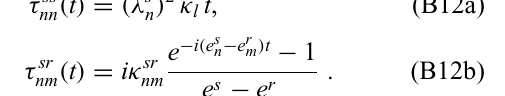
| ˆ J | φ + (cid:2) = 1 and that (λ + −+ n n